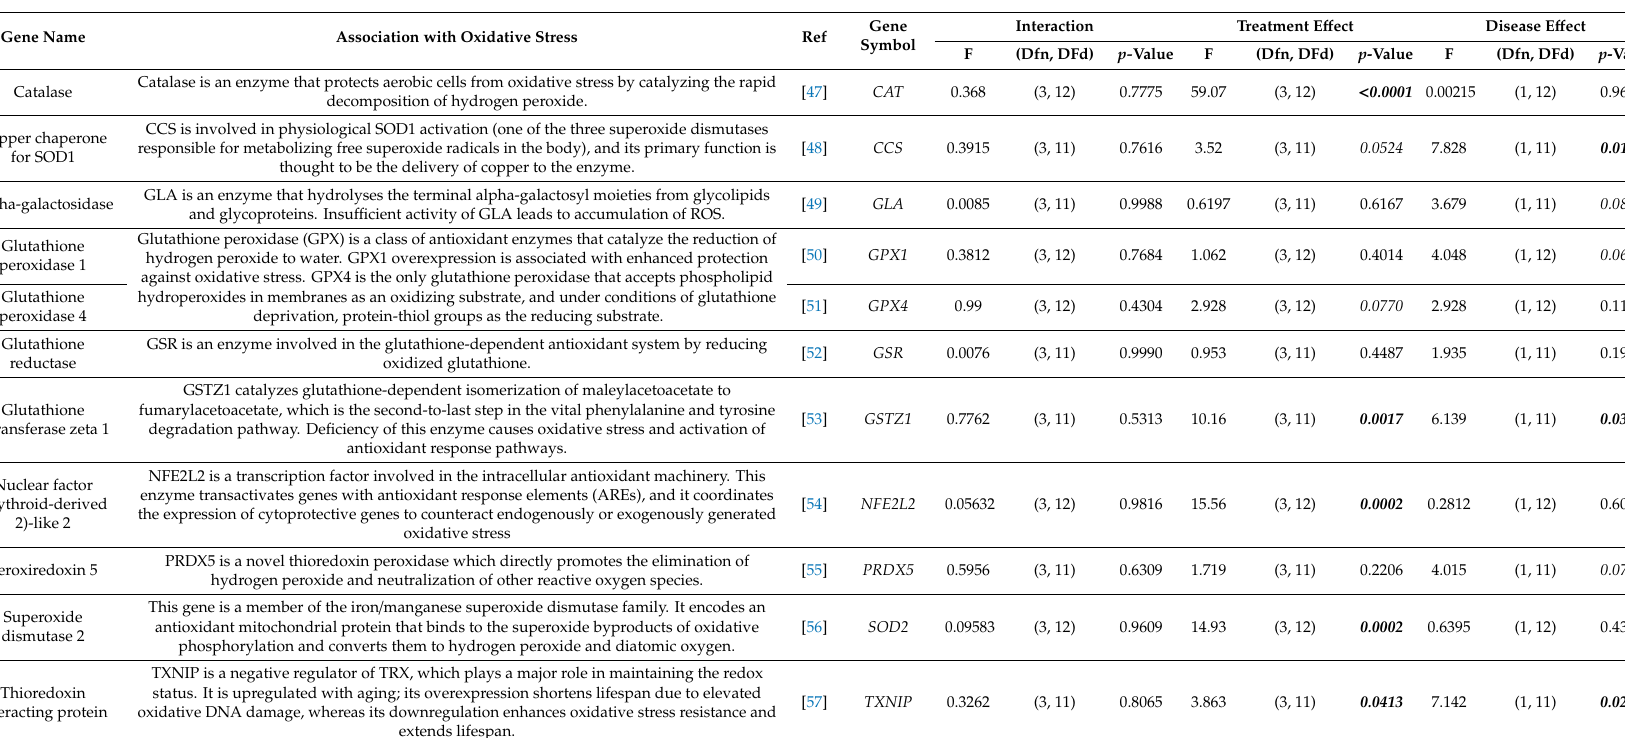
Table 1. Two-way ANOVA analysis of relative expression of genes involved in oxidative stress in AD and HC lymphoblasts treated with selenite (Se (IV)), selenate (Se (VI)), and resveratrol